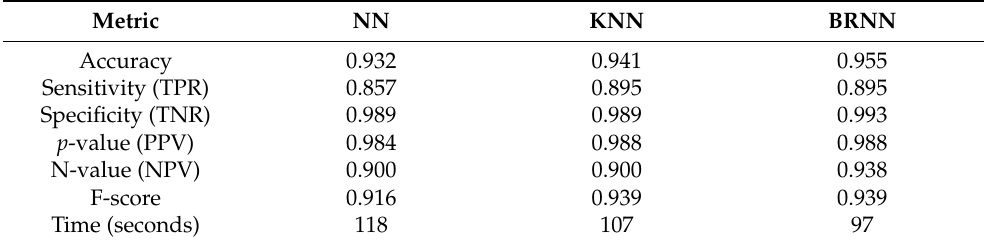
Table 10. Evaluation of the performance of machine learning models applied to the second dataset